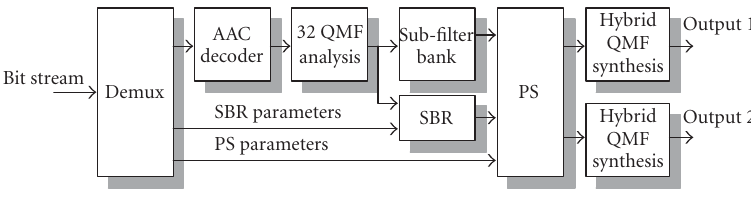
Figure 10: Structure of enhanced